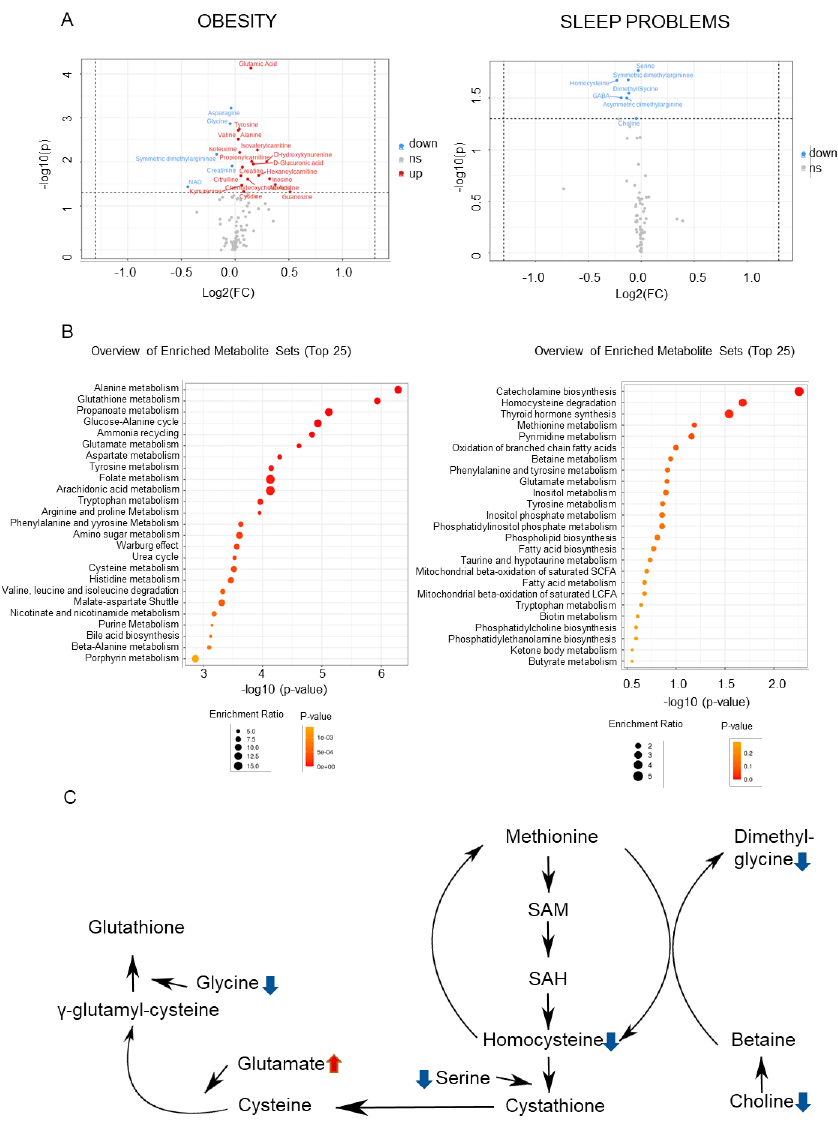
Figure 4. ( A ): Volcano plot showing the results for elucidating discerning markers between obese (BMI > 30) and non-obese patients, and those with recurring sleep problems, and those with normal sleep or only mild sleep problems. FC = 1, p -value < 0.05, BMI > 30/BMI < 30 and recuring/normal and mild sleep problems. ( B ): Top 25 metabolic pathways that pathway enrichment analysis using SMPDB database suggested as having the most alterations, on the left in relation to obesity, and on the right in relation to sleep problems. The figure has been created using the MetaboAnalyst software (version 5.0, https://www.metaboanalyst.ca/home.xhtml [28]. ( C ): Mechanistic model illustrating how problems co-occurring with chronic pain may link at the metabolomic level. On the partial description of methionine metabolism (right), the blue arrows show the four metabolomic markers that are decreased in the recurring sleep problems subgroup in statistical analysis, suggesting downregulated methionine metabolism in this subgroup. Methionine metabolism is an important source of cysteine, needed for glutathione metabolism (left), and which appeared altered with obesity. The figure was created using Microsoft PowerPoint ® (Redmond, WA, USA) on Microsoft Windows